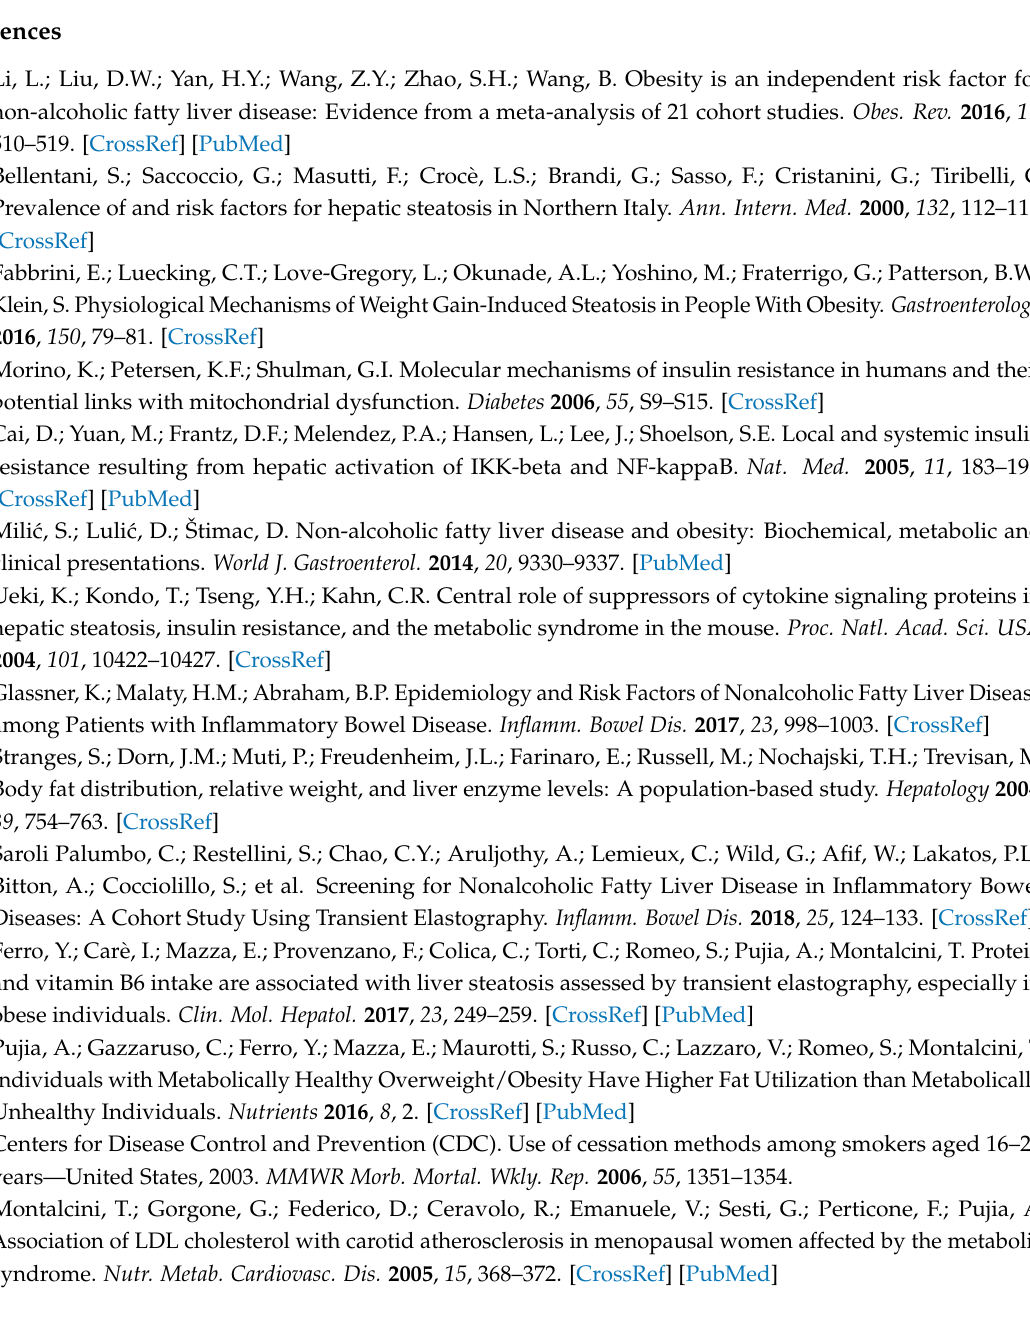
Figure S1: Prevalence in liver steatosis grade in patients with IBD, Figure S2: Prevalence of participants with a body weight gain > 6% according to the improved, stable and worsened liver fat content in